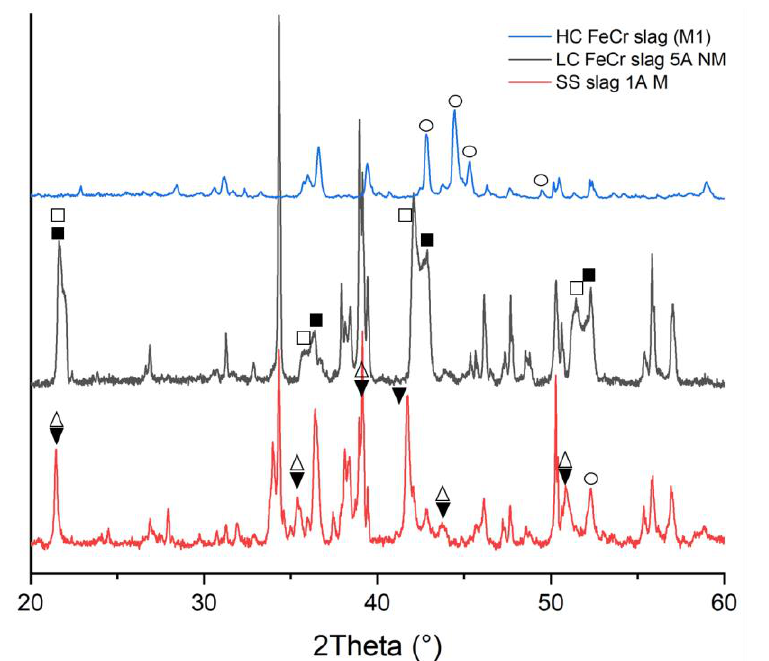
Figure 12. XRD patterns showing Cr-phases in the most up-concentrated fractions of SS, LC FeCr, and HC FeCr slag (not identified peaks belong mostly to Ca-(Mg-Al-)silicates like merwinite, bredigite, and akermanite).